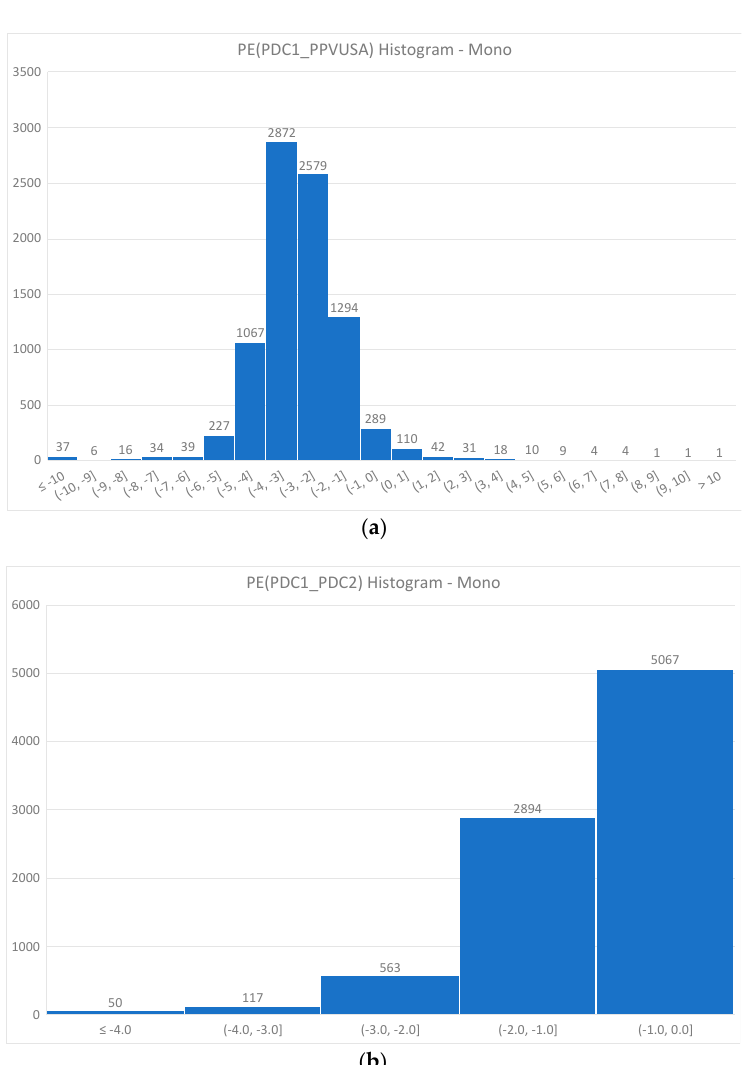
Figure 10. Histograms of the Percentage Error 𝑃𝐸 (cid:2869)(cid:3017)(cid:3023)(cid:3022)(cid:3020)(cid:3002) concerning 𝑃𝐷𝐶 (cid:2869)(cid:3017)(cid:3023)(cid:3020)(cid:3022)(cid:3002) and 𝑃 (cid:3017)(cid:3023)(cid:3022)(cid:3020)(cid:3002) ( a ), and the Percentage Error 𝑃𝐸 (cid:2870)(cid:3017)(cid:3023)(cid:3022)(cid:3020)(cid:3002) concerning 𝑃𝐷𝐶 (cid:2870)(cid:3017)(cid:3023)(cid:3022)(cid:3020)(cid:3002) and 𝑃𝐷𝐶 (cid:2869)(cid:3017)(cid:3023)(cid:3022)(cid:3020)(cid:3002) ( b ); monocrystalline modules.